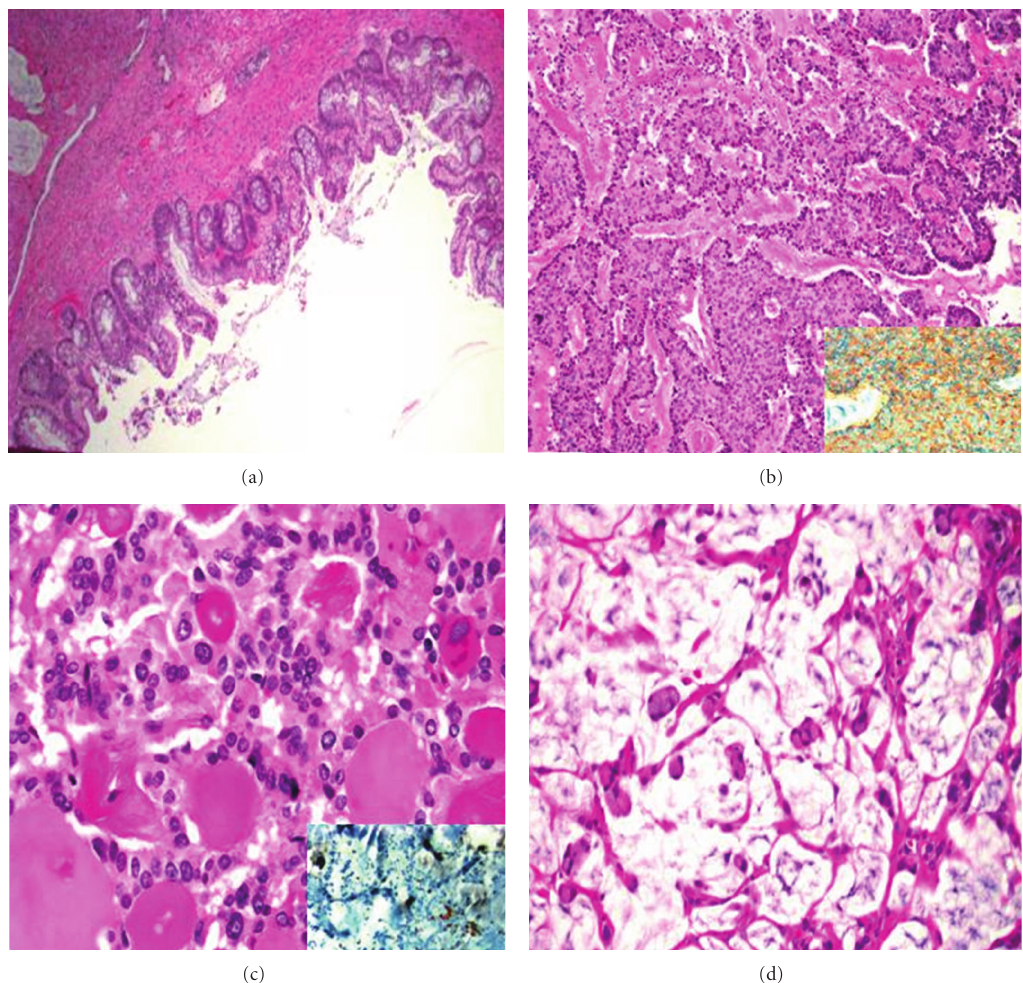
Figure 1: Malignant components in the teratoma. (a) Benign large bowel component of mature cystic teratoma. (b) Strumal carcinoid, strongly positive for synaptophysin stain (inset); (c) follicular variant of papillary thyroid carcinoma with positive nuclear staining for TTF1 (inset). (d) Infiltrating mucinous